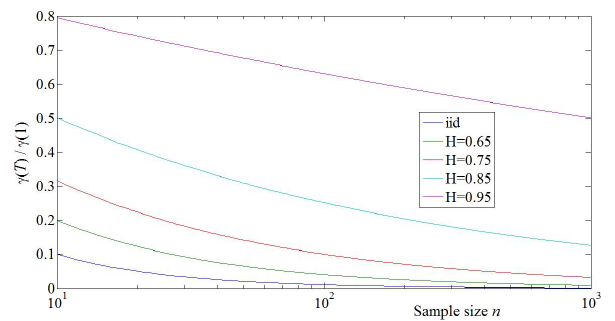
Fig. 2. Estimator variance of the mean of the local aver- = 1 ) age process x (1 standardized by the process variance, i.e. j = 1 ) = 1 ) Var[ m (1 ]/Var[ x (1 ] = γ(T ) / γ (1), plotted against the sample j 1 size n = T for 1 =